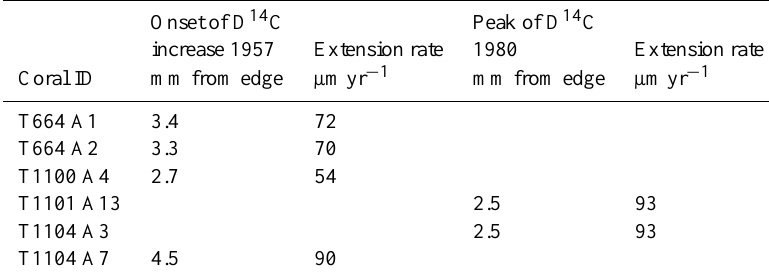
Table 3. Calculated radial extension rates based upon D 14 C and correlation to bomb